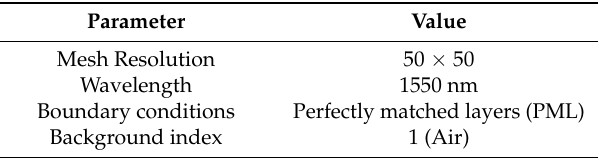
Table 2. Eigenmode solver settings.